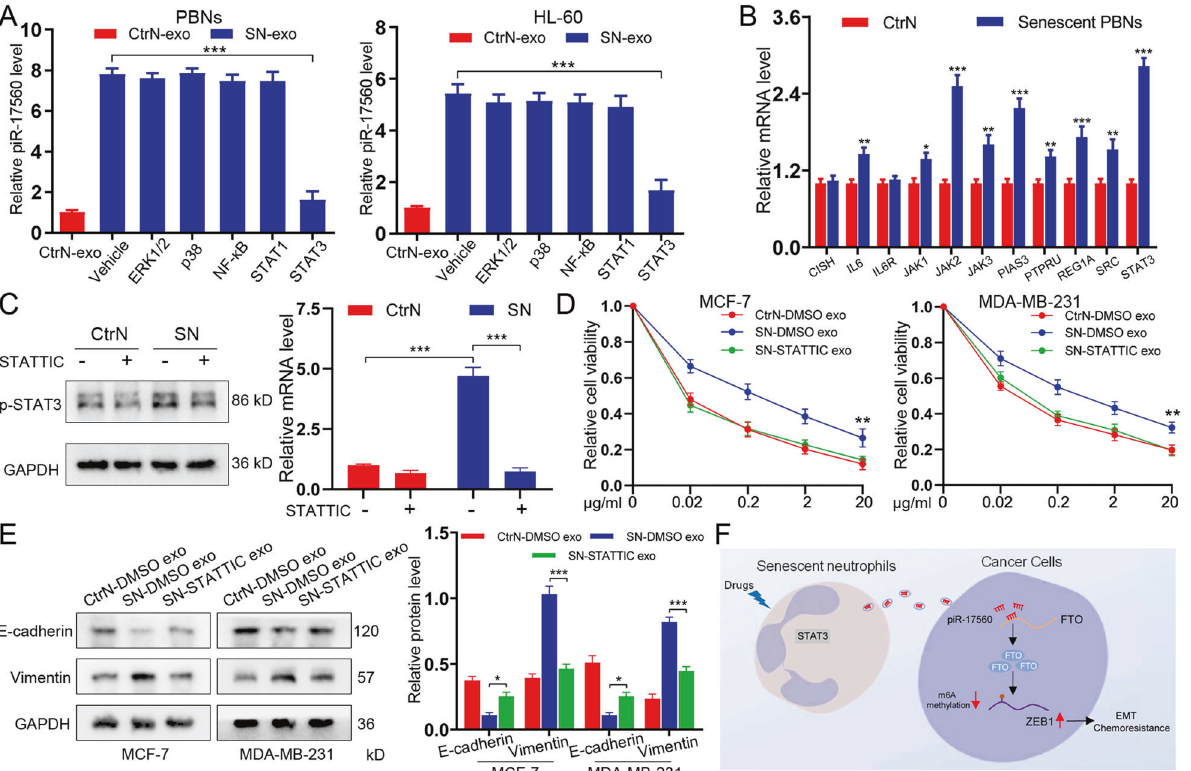
Fig. 7 Senescent neutrophils produce exosomal piR-17560 in a STAT3-dependent manner. A qPCR analysis of piR-17560 expression in PBNs and HL-60 cells treated with inhibitors of ERK1/2 (SCH772984), p38 (SB203580), NF- κ B (JSH-23), STAT1 (Fludarabine) and STAT3 (STATTIC) for 12 h. B qPCR analysis showing the enrichment of STAT3 activation signature in senescent neutrophils relative to controls. C Senescent or control neutrophils were treated with STATTIC (1 µM) for 24 h, and examined for p-STAT3 expression by immunoblotting. D CCK8 assay of MCF-7 and MDA-MB-231 cells pre-incubated with indicated exosomes for 48 h followed by docetaxel at different concentrations for 48 h. E Immunoblotting of E-cadherin and Vimentin in tumor cells re-incubated with indicated exosomes for 48 h. F Schematic model for senescent neutrophils in promoting chemoresistance and EMT of breast cancer cells via exosomal piR-17560. Data represent the mean ± SD of at least three independent experiments. * P < 0.05, ** P < 0.01, *** P <